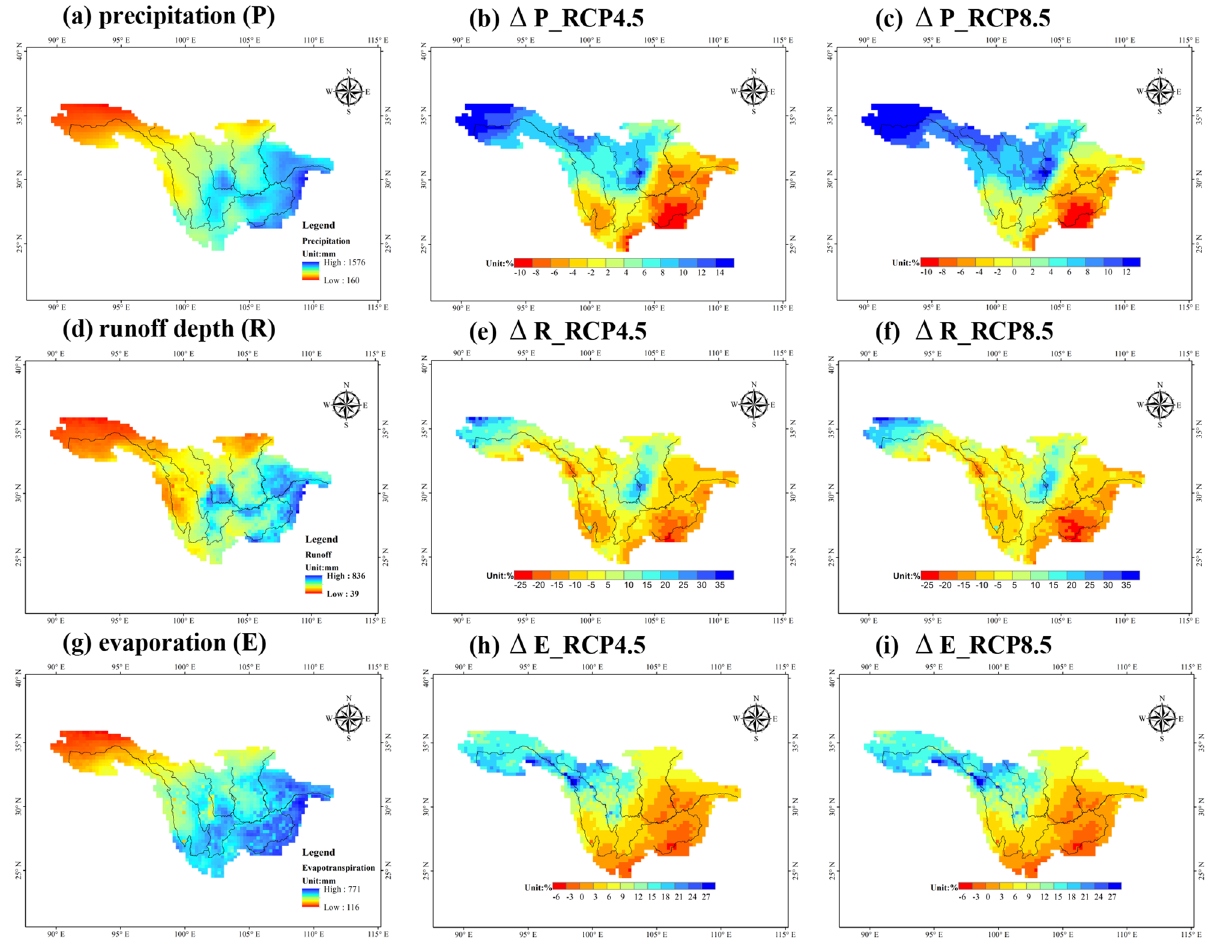
Figure 11. Spatial distribution of multiyear average precipitation ( a , unit: mm), runoff depth ( d , unit: mm) and evaporation ( g , unit: mm) over the UYRB in the reference period and the corresponding changes (unit: %) under the RCP4.5 and RCP8.5 scenarios. The figure was generated by Arcmap 10.6 (https:// www. esri.